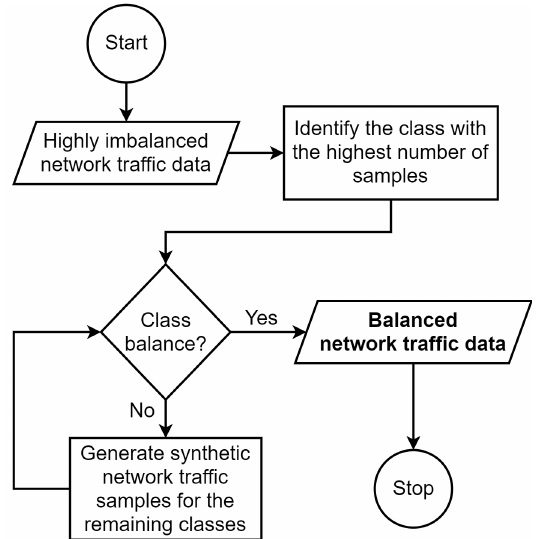
Figure 3. SMOTE method for the generation of synthetic network traffic